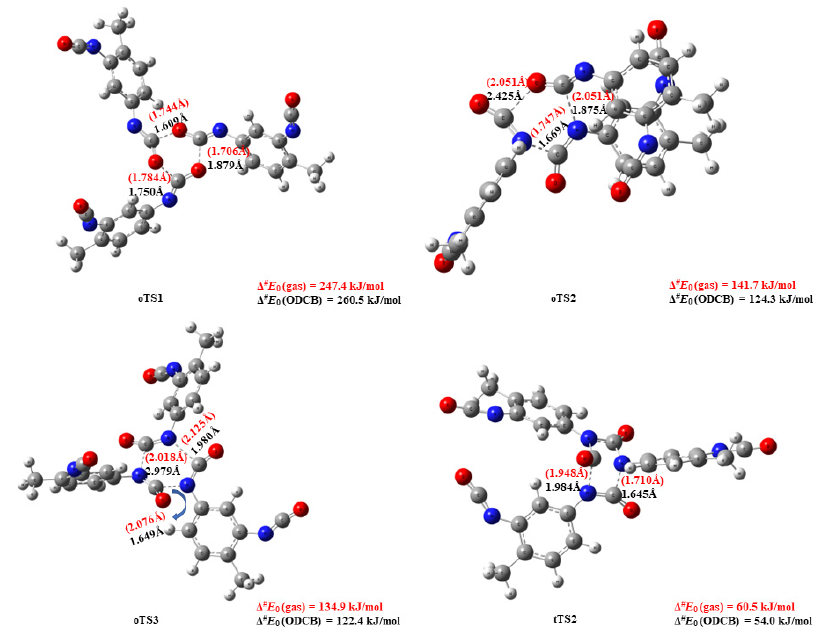
Figure 7. Transition state structures of the trimerization of TDI in the gas phase and the ODCB en- vironment. The energy values were obtained using the qG3MP2B3 protocol. environment. The energy values were obtained using the qG3MP2B3